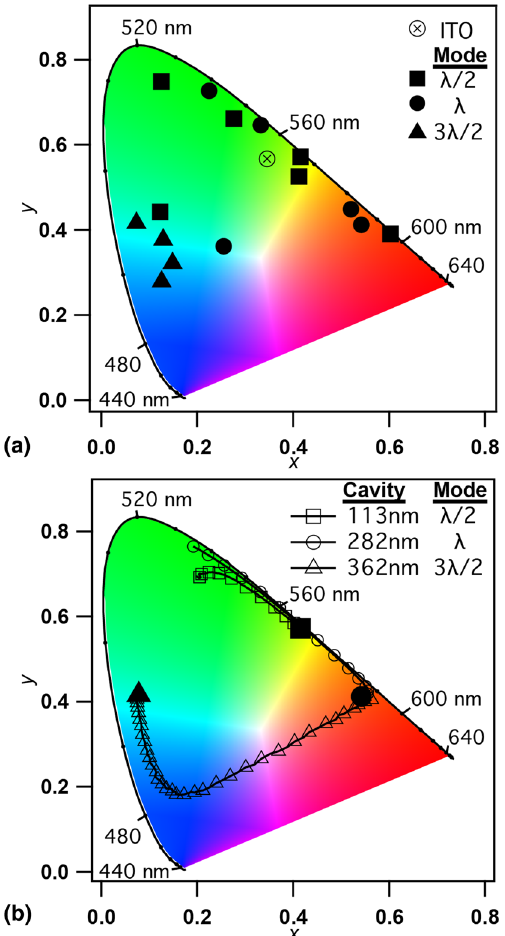
Figure 6. CIE 1931 color coordinates of the perceived emission from ( a ) microcavities at normal incidence with an ITO-based Alq 3 OLED indicated as the symbol for reference and, ( b ) microcavity OLEDs for (cid:31) / 2 ⊗ mode, (cid:31) mode, and 3 (cid:31) / 2 mode observed at angles from 0 ◦ to 70 ◦ . Normal emission is indicated with the solid, larger symbol and the open symbols of the same shape proceed generally counterclockwise around the color gamut with increasing